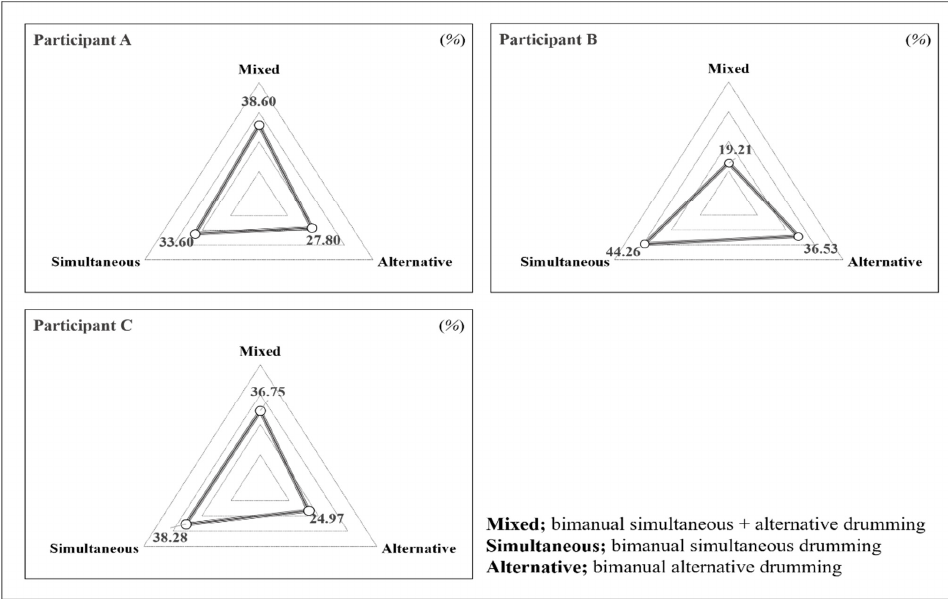
Figure 3. The ratio of each type of drum playing (i.e., simultaneous, alternative, or mixed) across the 12 sessions of the intervention.